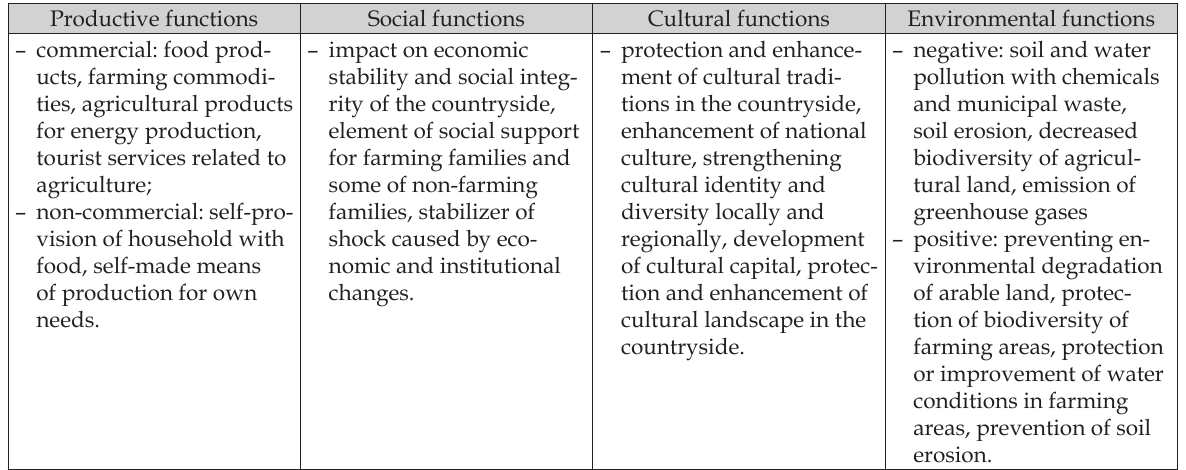
Table 1. classification of commercial and non-commercial functions of agriculture, acc. Wilkin (2010: 65). Productive